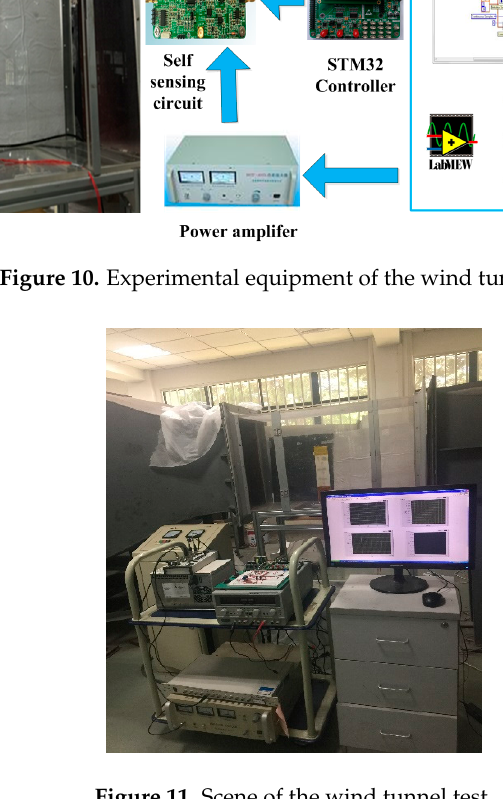
Figure 11. Scene of the wind tunnel test.